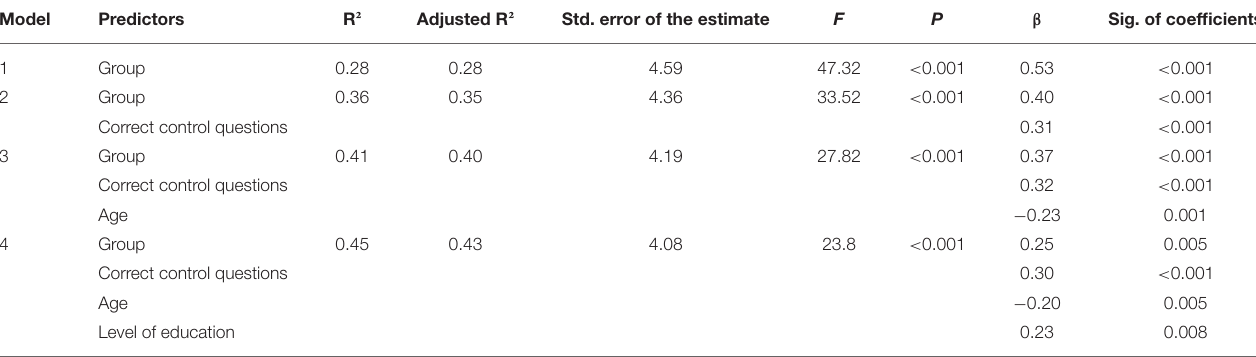
TABLE 3 | Multiple linear regression predicting MASC total scores using the forward selection